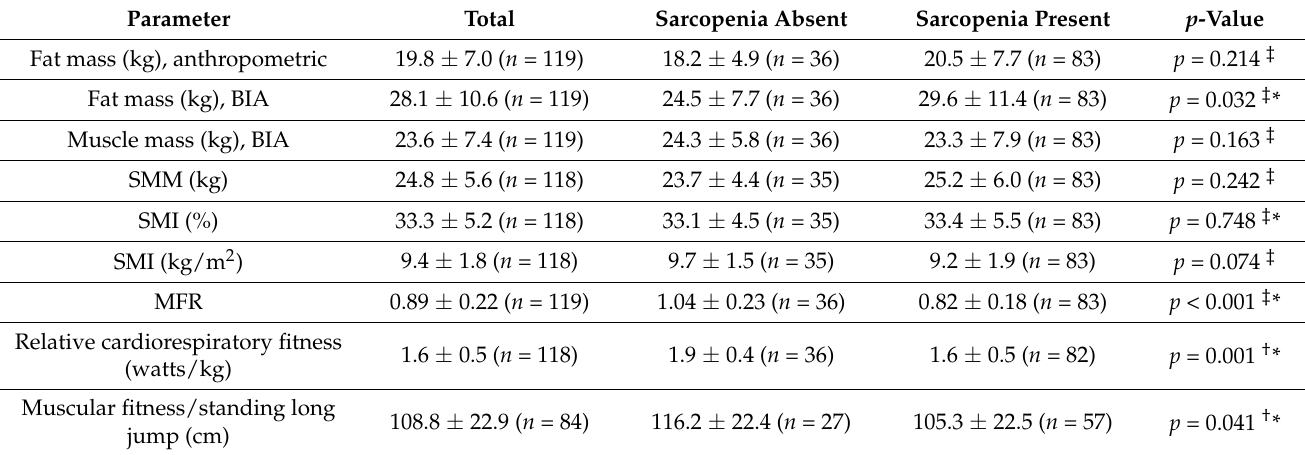
Table 3. SMM, SMI, MFR, cardiorespiratory, and muscular fitness of the whole group and by the presence of